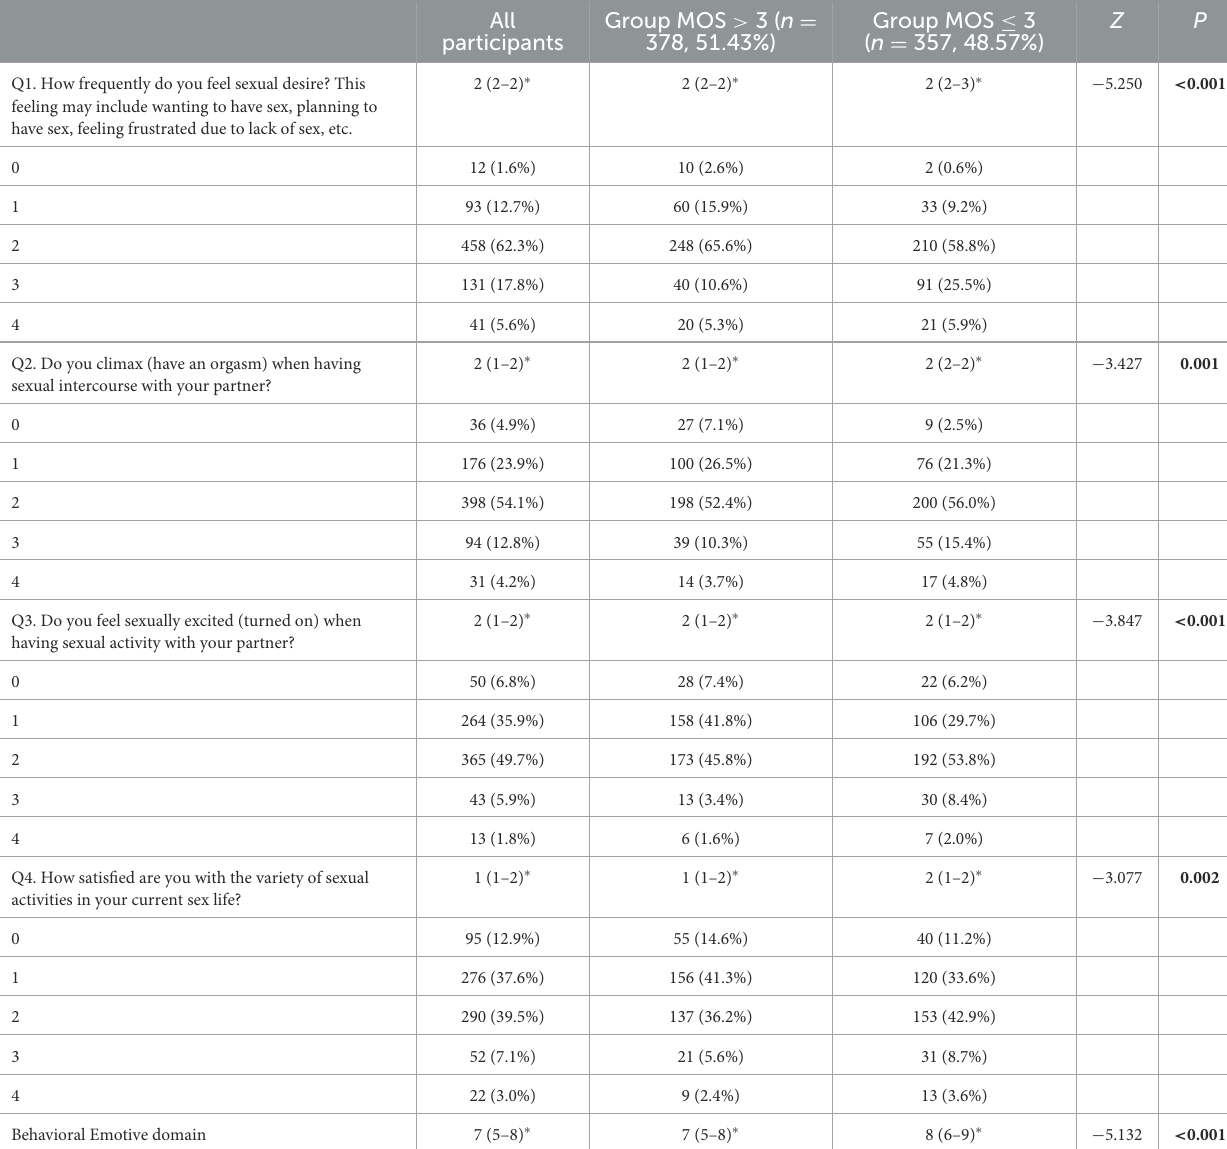
TABLE 4 The behavioral emotive domain of PISQ-12 for all participants and univariate analysis results of the two groups.